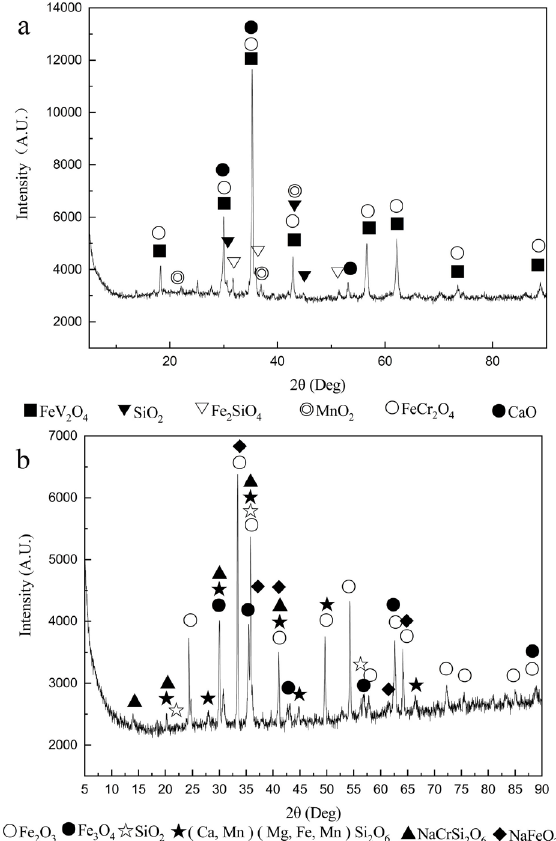
Figure 1. The XRD patterns of vanadium slag and vanadium residue. a: vanadium slag, b: vanadium